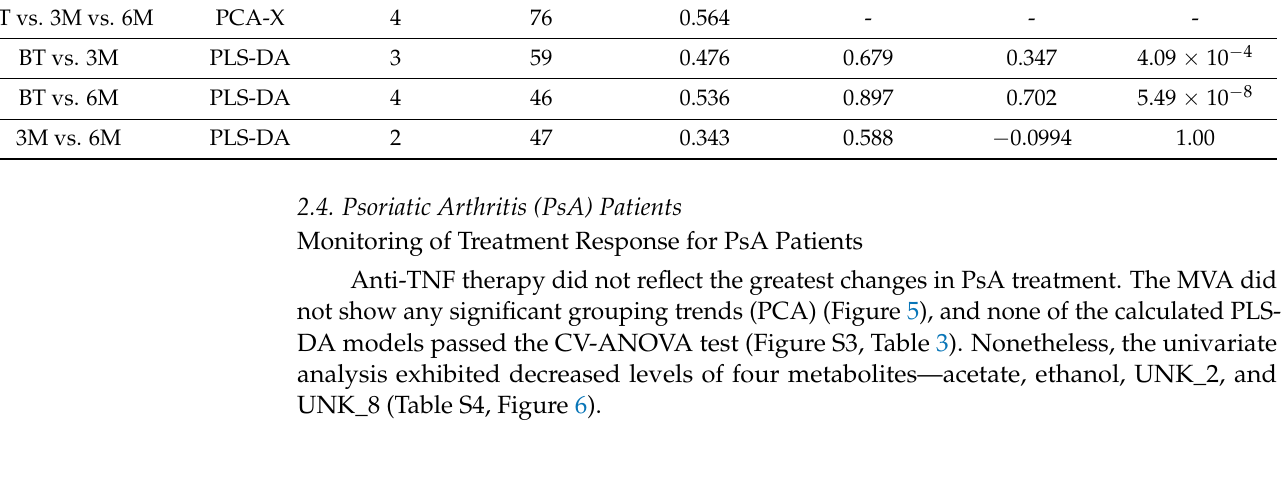
Figure 3. PCA model plot and corresponding loading plot for AS patients studied at three time points. Red — AS patients before treatment; blue — 3 months after initialization of anti-TNF treatment; green — 6 months after treatment with TNFi. Table 2. The multivariate analysis models summary for AS patients’ treatment influence.